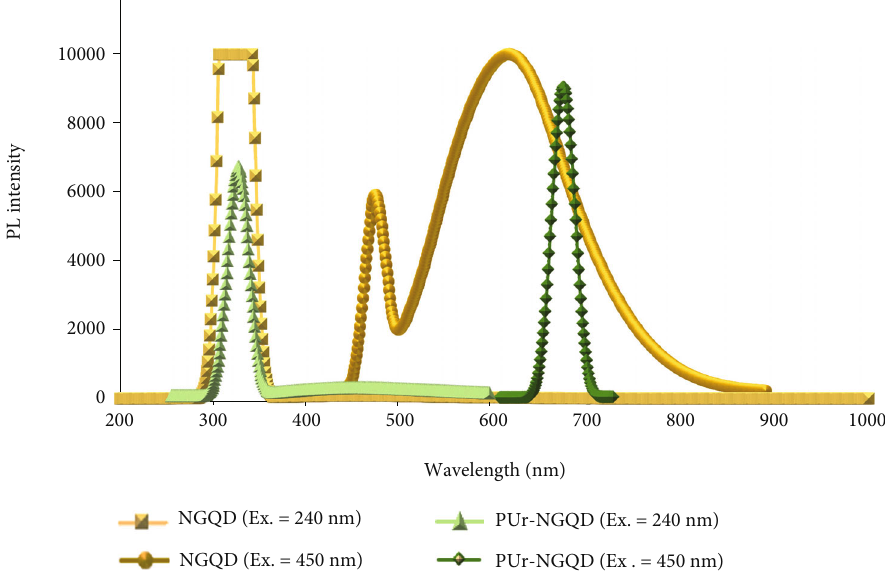
Figure 8: PL spectra of NGQD and